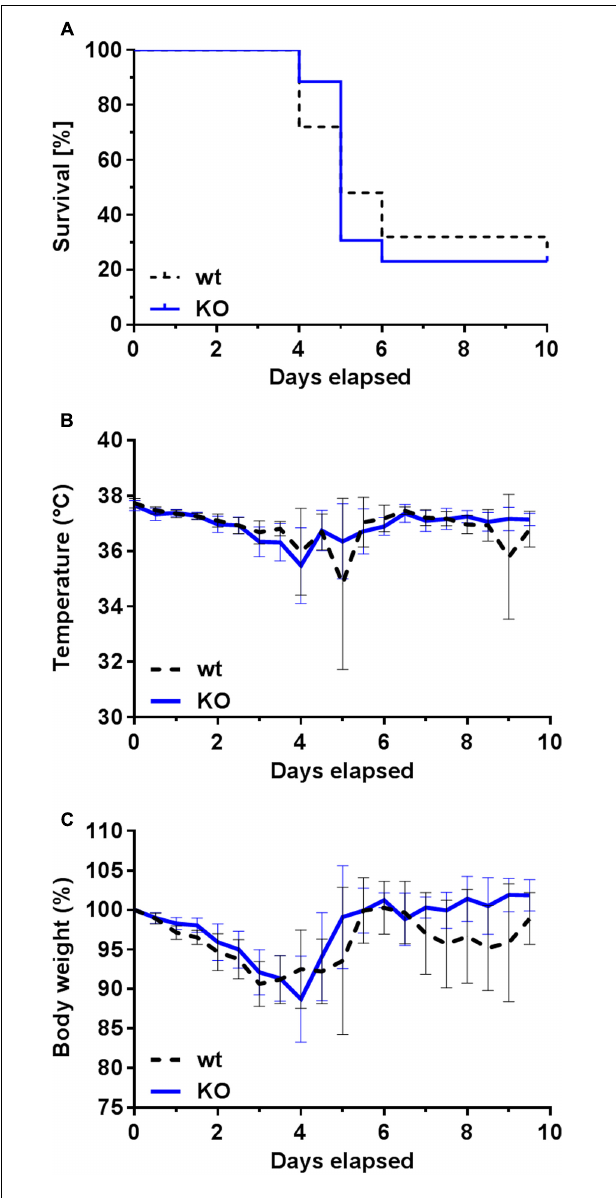
FIGURE 6 | Survival rate and clinical signs of infected wt and PGLYRP3KO mice. Female BALB/c mice were intranasally infected with 10 5 CFUs S. pneumoniae (NCTC 7978) per mouse. The survival was recorded every 12 h for 10 days. There was no significant difference observed between the two groups (A) . In total 25 wt and 26 PGLYRP3KO mice were used. Statistical analysis was done by log rank (Mantel–Cox) test. Every 12 h the clinical symptoms including temperature in ◦ C (mean ± 95% CI) (B) and body weight shown in % of initial body weight (mean ± 95% CI) (C) were recorded in these mice. There were no differences between wt and PGLYRP3KO mice detectable neither in the progress of the temperature curve nor in the body weight